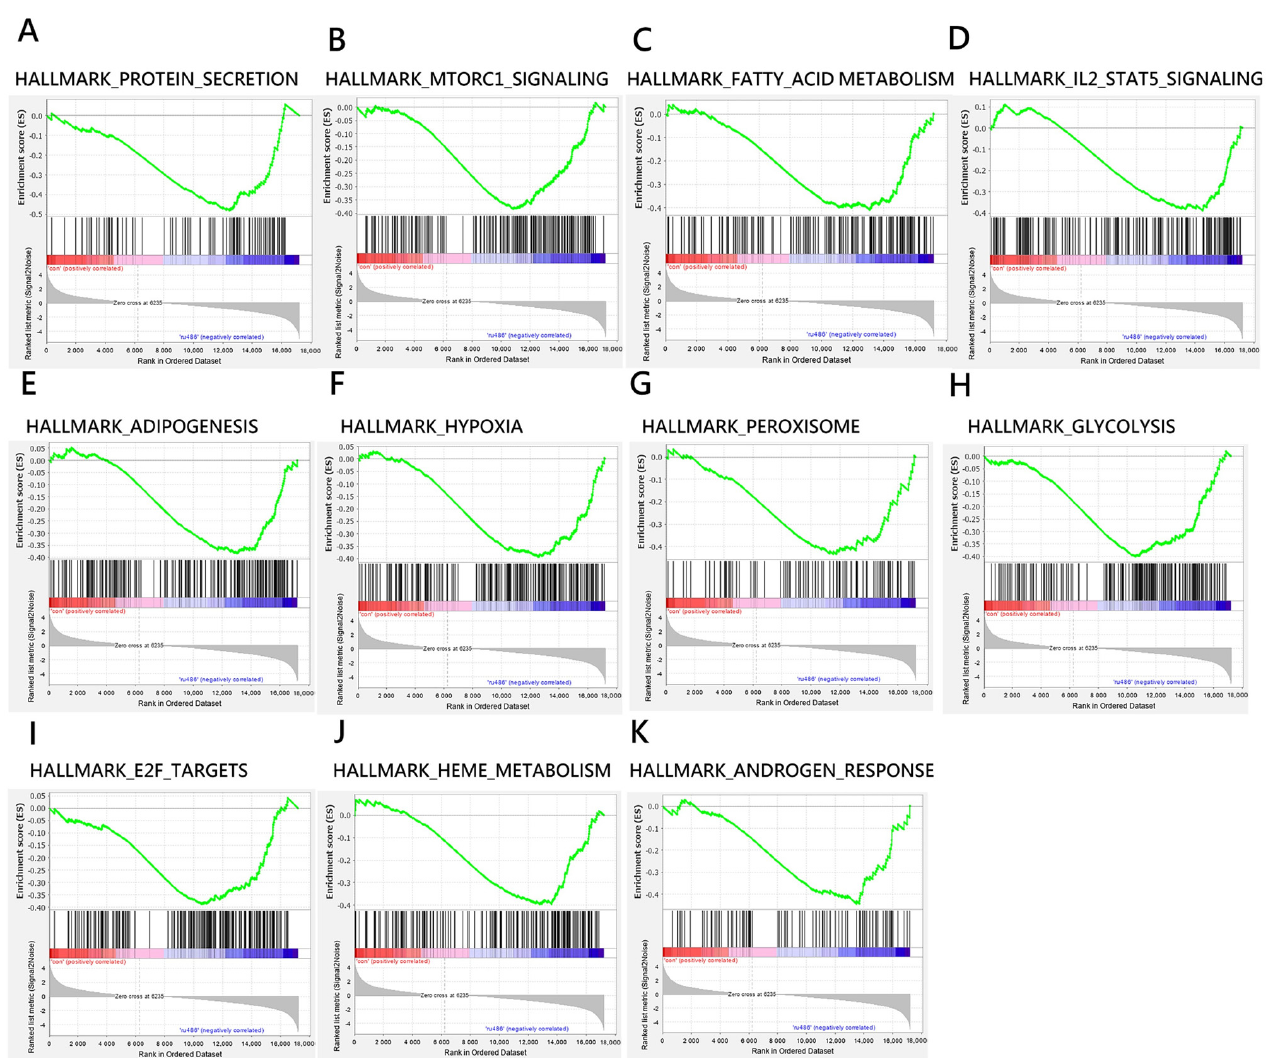
Figure 3. Enrichment plots indicated significantly enriched gene sets (FDR q -value < 0.25; NOM p -value < 0.05) for embryos treated with RU-486 compared with mock control. ( A – K ) show negative enriched score (ES) where the leading edge subset appears in the valley score of the subsequent ranked list.